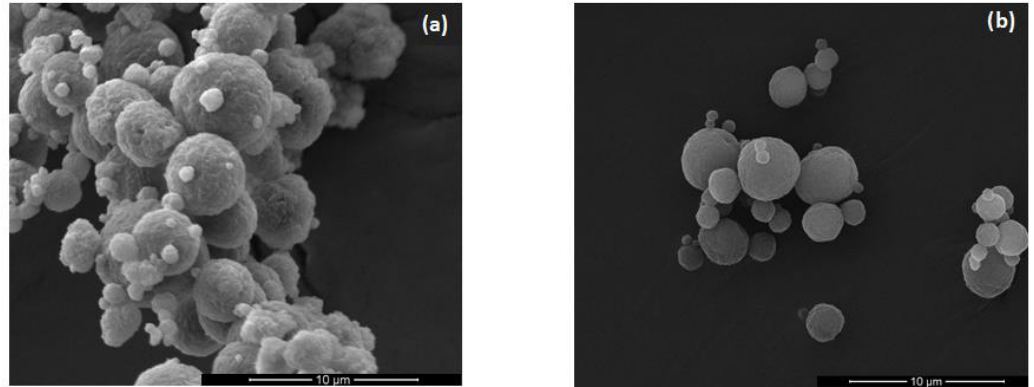
Figure 2. SEM picture of microparticles prepared using: ( a ) Surelease ® , ( b ) Aquacoat ® ECD under magnification 10,000×.